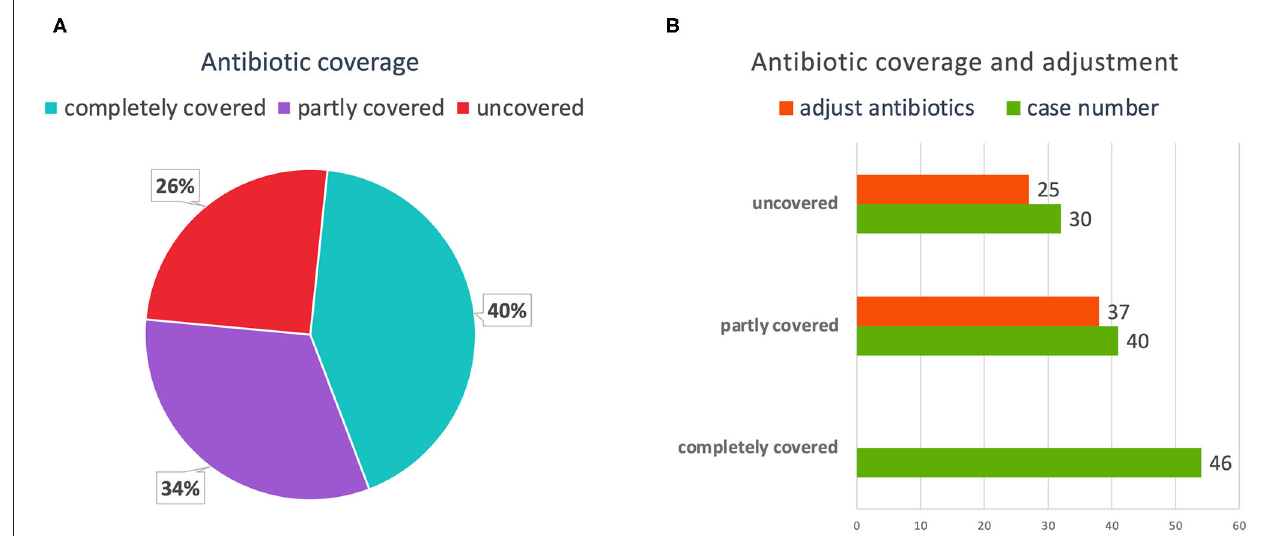
FIGURE 6 | The coverage and adjustment of antibiotics in the mNGS group. (A) Among patients in the mNGS group, complete antibiotic coverage was 54 (43%); partial coverage was 41 (32%); and no coverage was 32 (25%). (B) Antibiotics were adjusted for 38 partially covered patients, and for 27 uncovered patients. mNGS, metagenomic next-generation